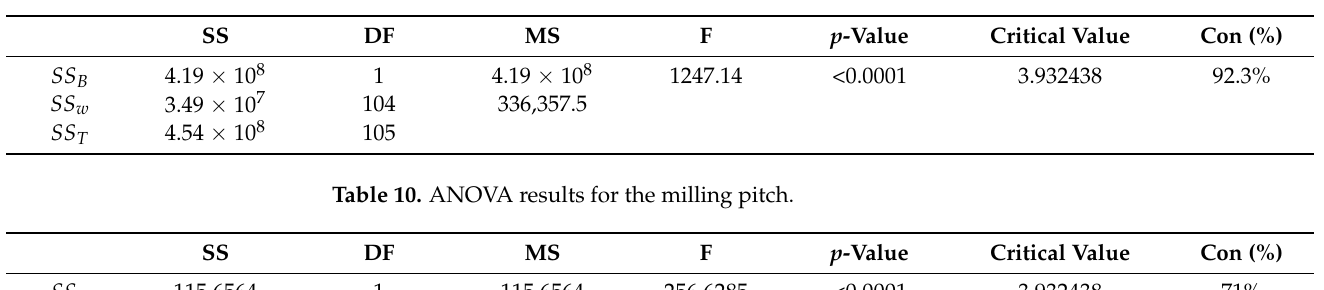
Table 9. ANOVA results for the feed.